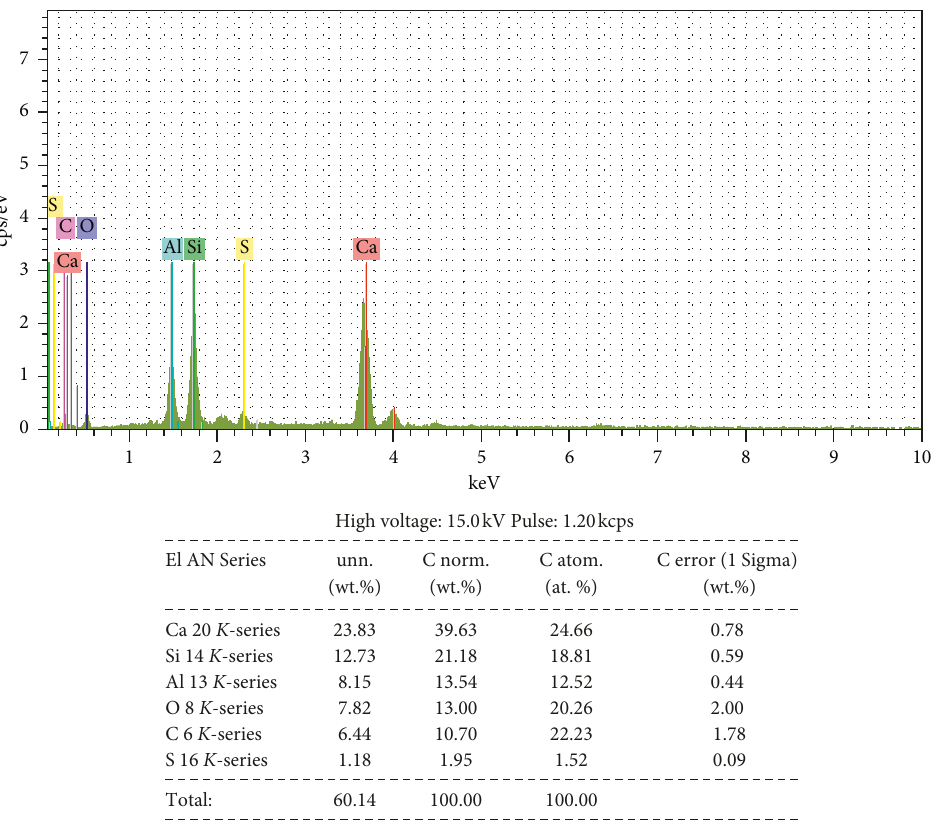
Figure 9: EDS for hydration